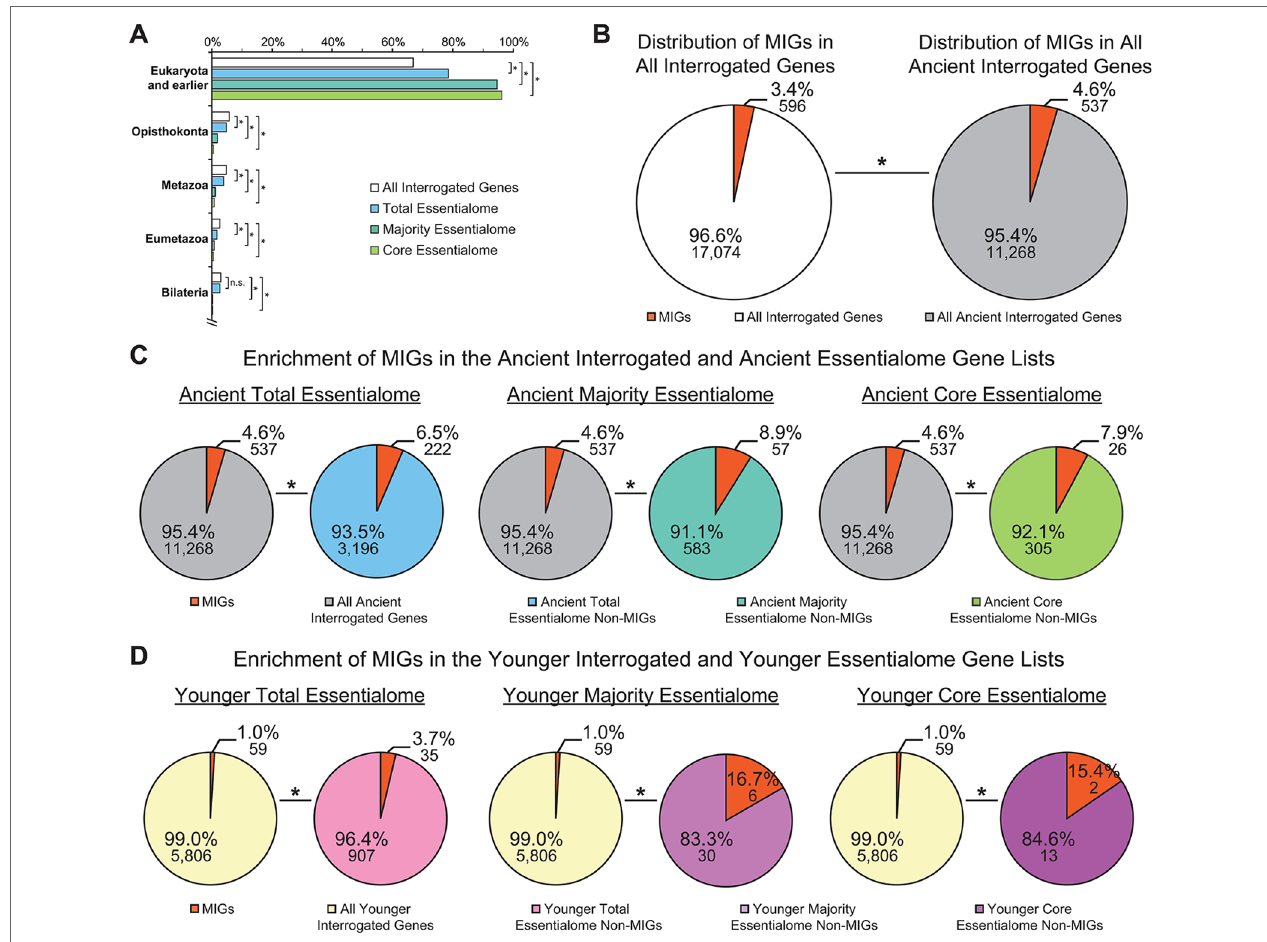
FIGUrE 4 | Minor intron-containing genes (MIGs) are enriched in essential genes regardless of age. (A) Evolutionary age of all interrogated genes (white), the total essentialome (blue), the majority essentialome (teal), and the core essentialome (green). Clades are listed on the y-axis. The x-axis shows the percentage of genes that can be traced to the listed clade, but not to an older clade. (B) Pie charts showing the enrichment of MIGs (orange) in the all interrogated genes (left) and all ancient genes (tracing back to Eukaryota and earlier; right). (C) Pie charts showing the enrichment of MIGs (orange) in the ancient total essentialome (blue, left), the ancient majority essentialome (teal, middle), and the ancient core essentialome (green, right), compared to all ancient interrogated genes (gray). (d) Pie charts showing the enrichment of MIGs (orange) in the younger (tracing back to Opisthokonta or later) total essentialome (pink, left), the younger majority essentialome (light purple, middle), and the younger core essentialome (dark purple, right), compared to all younger interrogated genes (yellow). Statistical significance, relative to the percentage of MIGs present in the respective interrogated gene lists, was determined by Fisher’s exact test. N.s., not significant; * P ≤